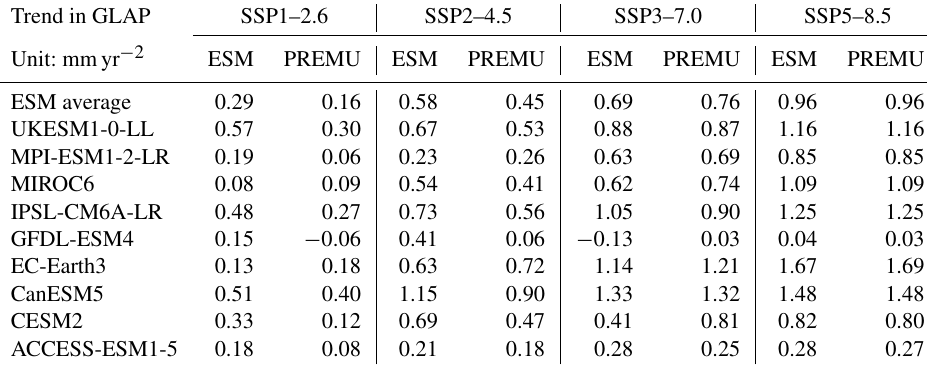
Table 4. Trend of GLAP from ESM average and each ESM and its corresponding emulation by PREMU during the period 2015–2100 under four scenarios. The ESM average represents the multi-model mean precipitation predicted by gridded temperature from nine ESMs. Note that the unit is mmyr − 2